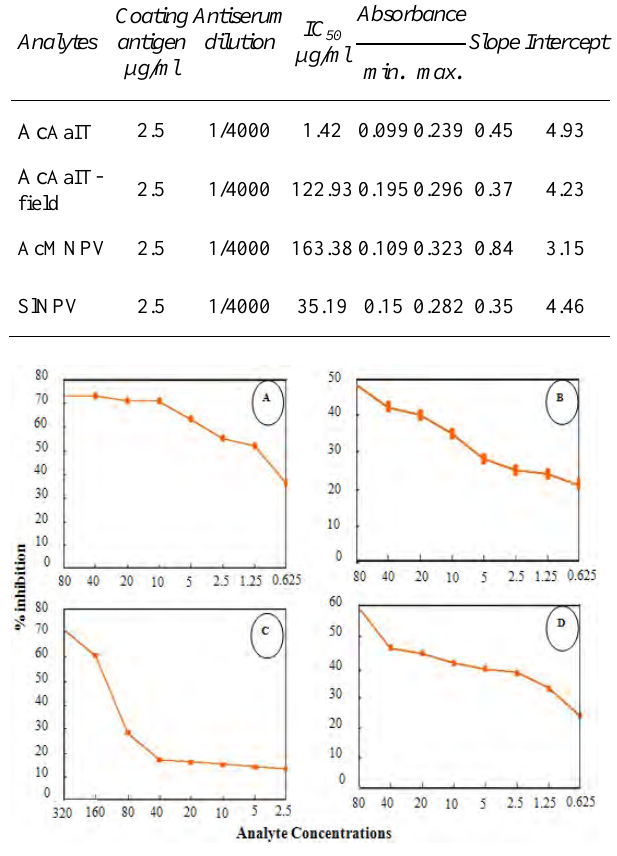
Figure 3: ELISA inhibition curves for 4 analytes: polyhedrin from AcAaIT (A), AcAaIT-field (B), AcMNPV (C), and SlNPV (D). Reagent concentrations: antiserum 1:4,000 (final dilution in wells); AcAaIT polyhedrin (2.5 µg/ml) was used as the coating antigen. Table 3: Cross-reactivity of serum against AcAaIT polyhedrin